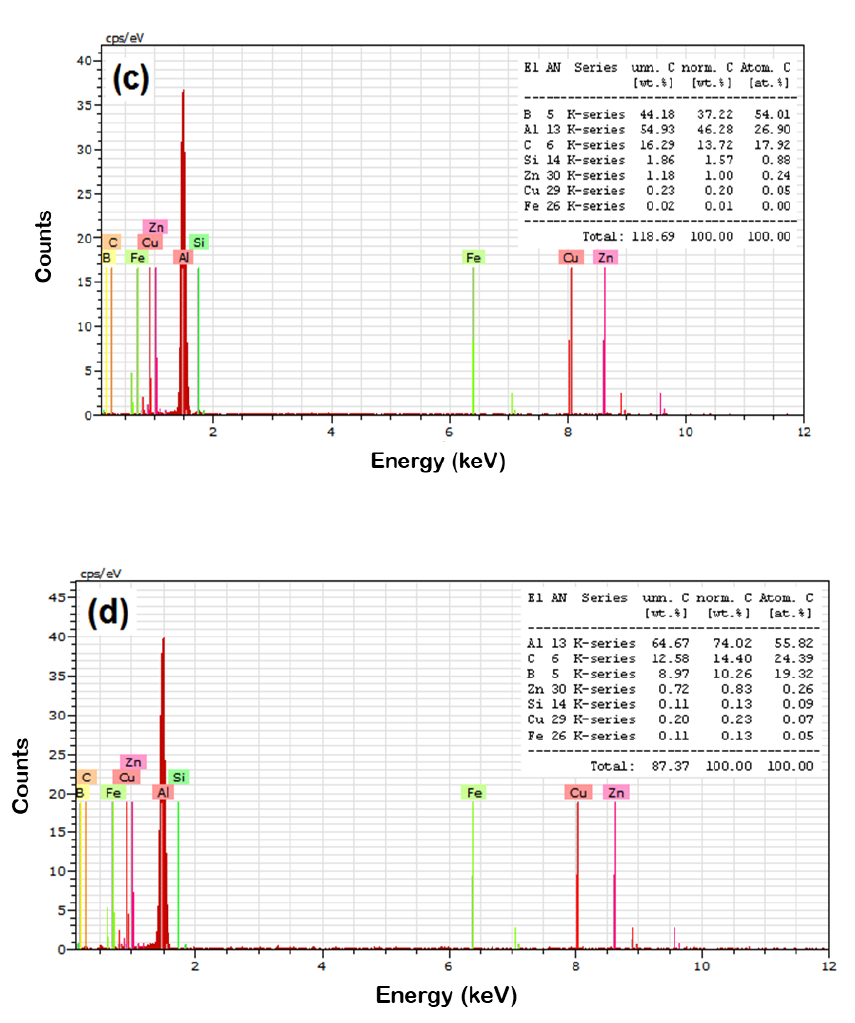
Figure 5. EDAX of sintered ( a ) AA8079, ( b ) AA8079-5% B 4 C, ( c ) AA8079-10% B 4 C, and ( d ) AA8079- 15% B 4 C composite preforms.